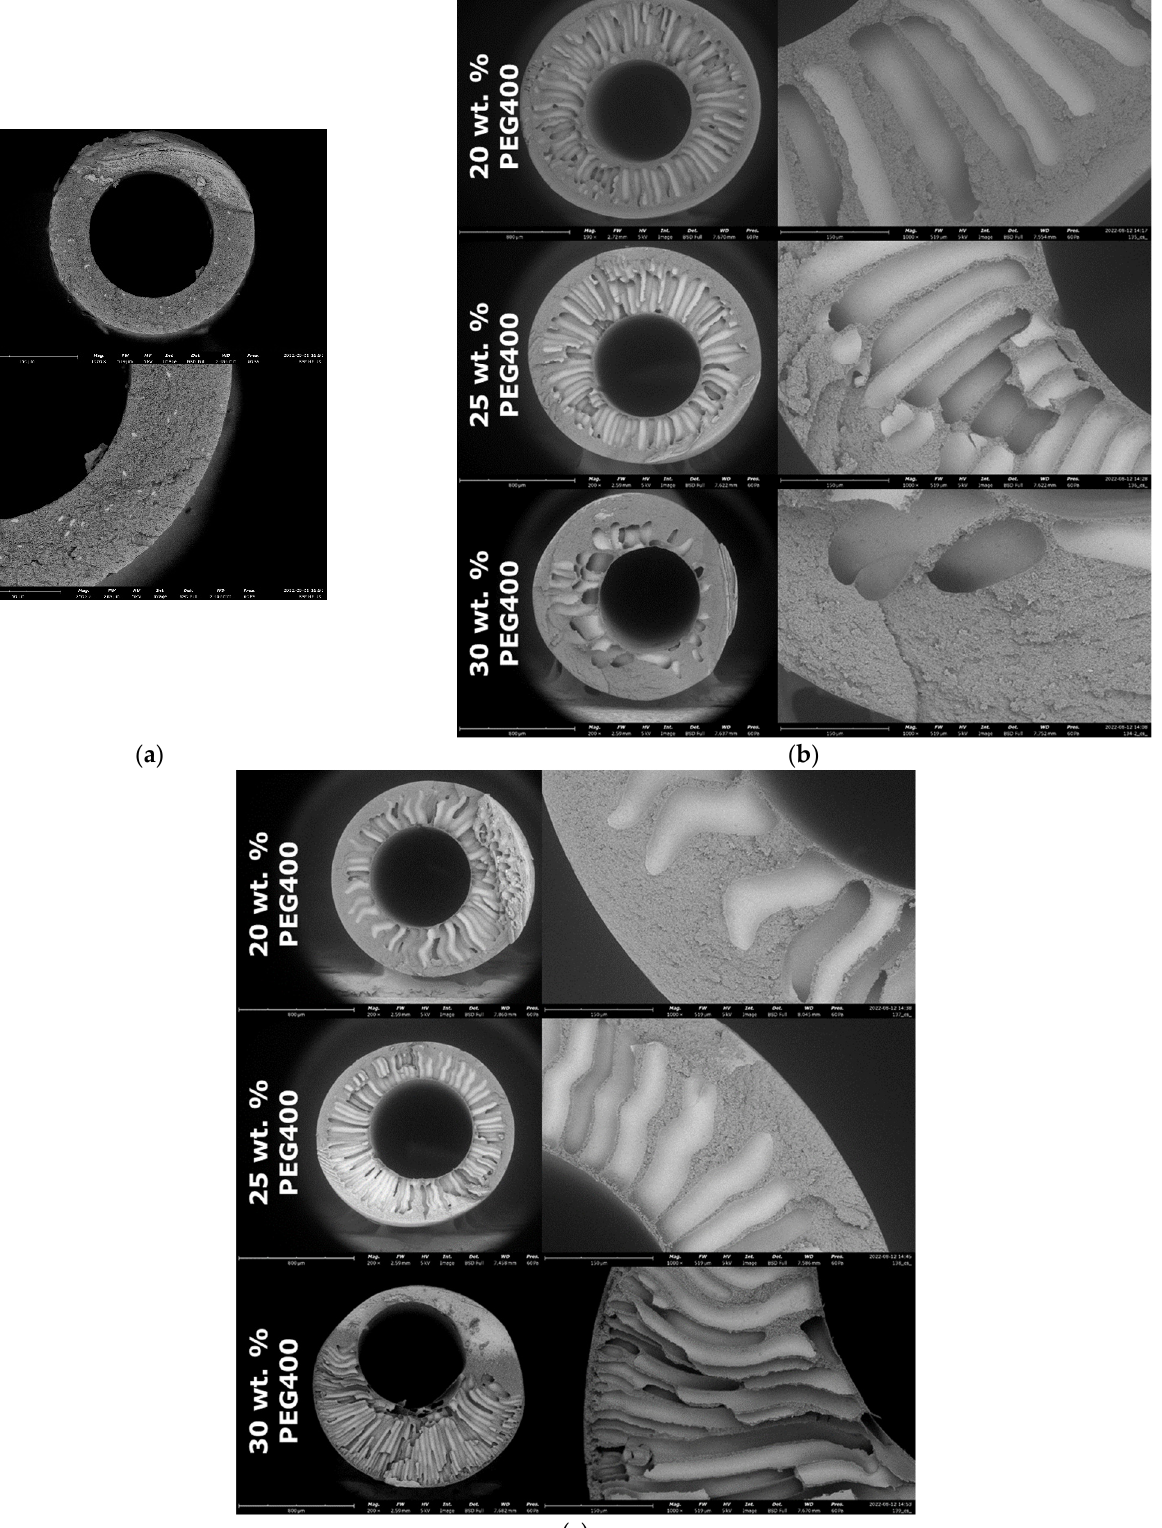
Figure 7. SEM photos of hollow fiber membranes obtained from PPSU-5 casting solutions: ( a ) 20 wt. % PPSU-5 hollow fiber without PEG; ( b ) 18 wt. % PPSU-5 hollow fiber with PEG400 added; ( c ) 20 wt. % PPSU-5 hollow fiber with PEG400